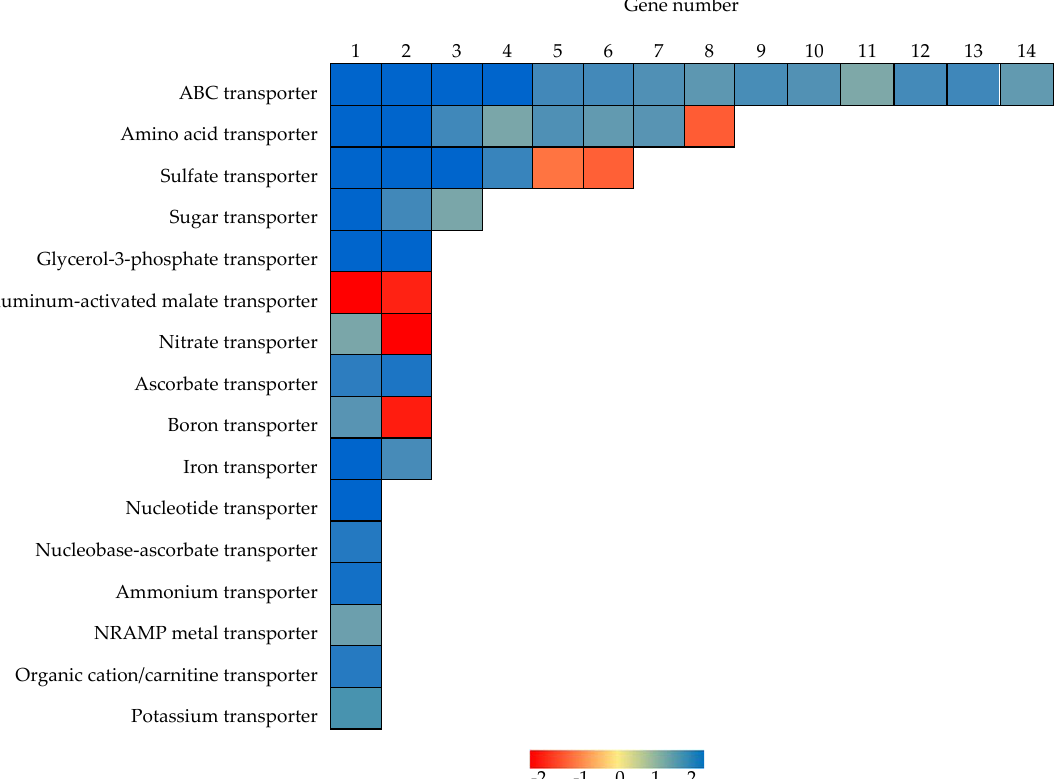
Figure 4. Heatmap analysis of P responsive DEGs associated with transport in nodules. Blue and red represent up-regulated and down-regulated expression, respectively, in response to Pi starvation within soybean nodules. Numbers represent fold changes in expression levels expressed as Log 2 (LP/HP).